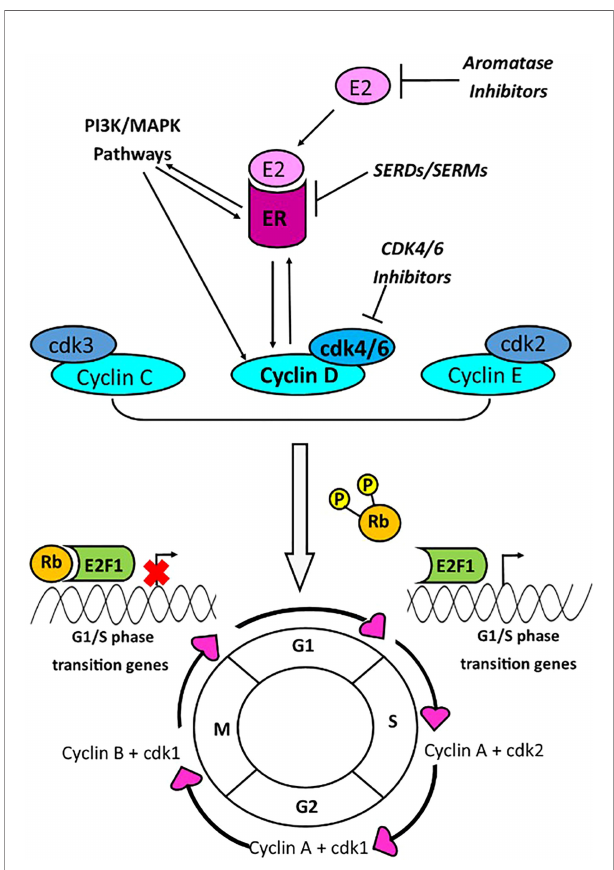
FIGURE 1 | Cyclin D1 promotes G1/S phase cell cycle progression via interaction with CDK4/6. Transition between phases of the cell cycle is mediated by cyclins A-E, and cyclin dependent kinases (cdk) 1-6. Cyclins C-E are responsible for the transition from G1 to S phase of the cell cycle. The cyclin D and cdk4/6 complex, activated by PI3K/MAPK pathways or the estrogen receptor (ER), is a key mediator of G1-S phase transition, and this occurs through phosphorylation of retinoblastoma protein (Rb). Phosphorylation of Rb, results in its dissociation with E2F1, enabling transcription of G 1 /S phase genes. Transcriptional activity of the ER is stimulated by cyclin D1, and the ER may activate the CCND1 promoter. Current breast cancer drugs target estrogen production (aromatase inhibitors); the estrogen receptor [Selective Estrogen Receptor Modulators (SERMs) or Selective Estrogen Receptor Degraders (SERDs)]; or cdk4/6 (cdk4/6